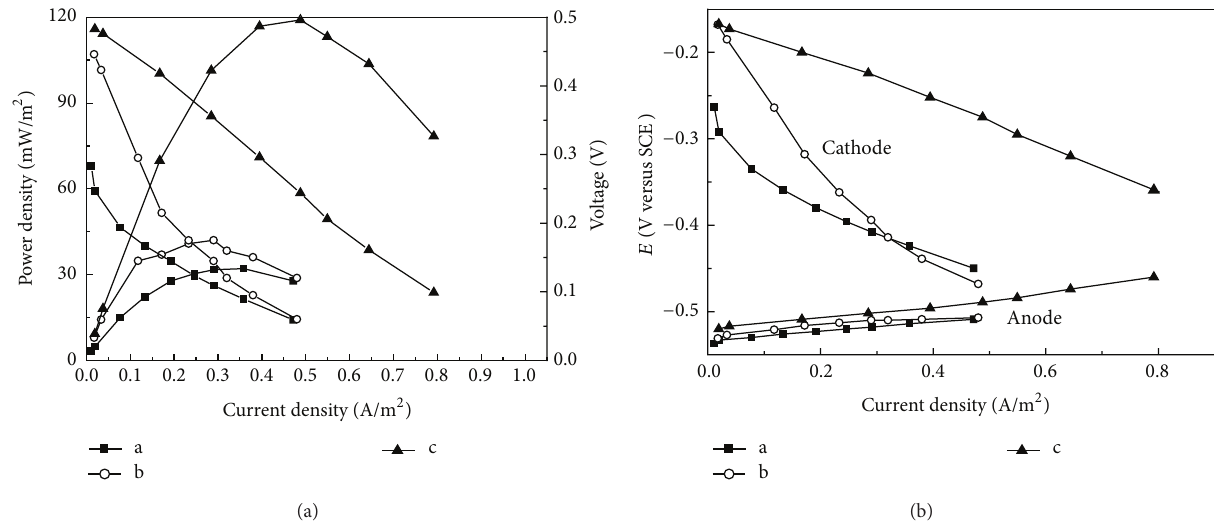
Figure 4: Performance of MFC equipped with different catalysts. (a) Cathode without loading catalyst; (b) cathode loading with NSM; (c) cathode loading with